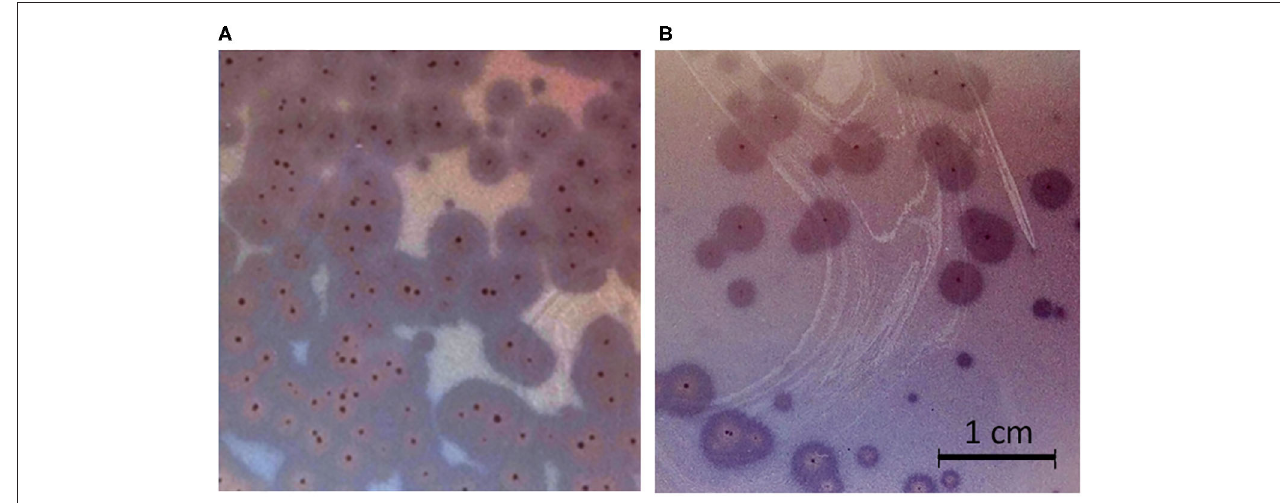
FIGURE 1 | Plaque morphology. (A) Phage ISTD. (B) Phage